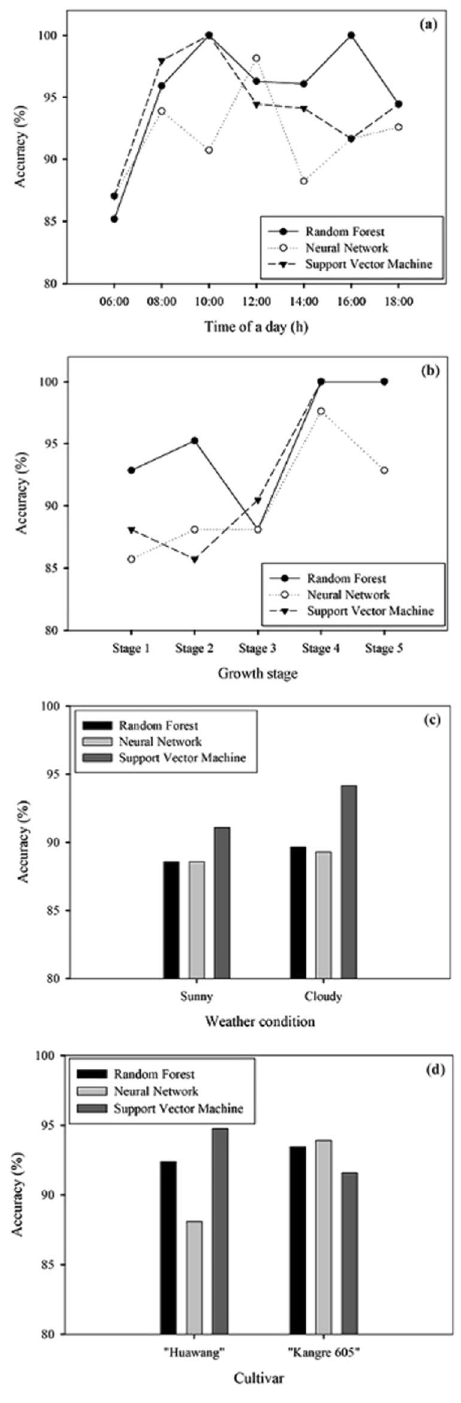
Figure 5. Classification accuracy of developed models in different scenarios. ( a ) Different time of a day, ( b ) growth stage from stage 1 to stage 5, ( c ) weather condition, and ( d )